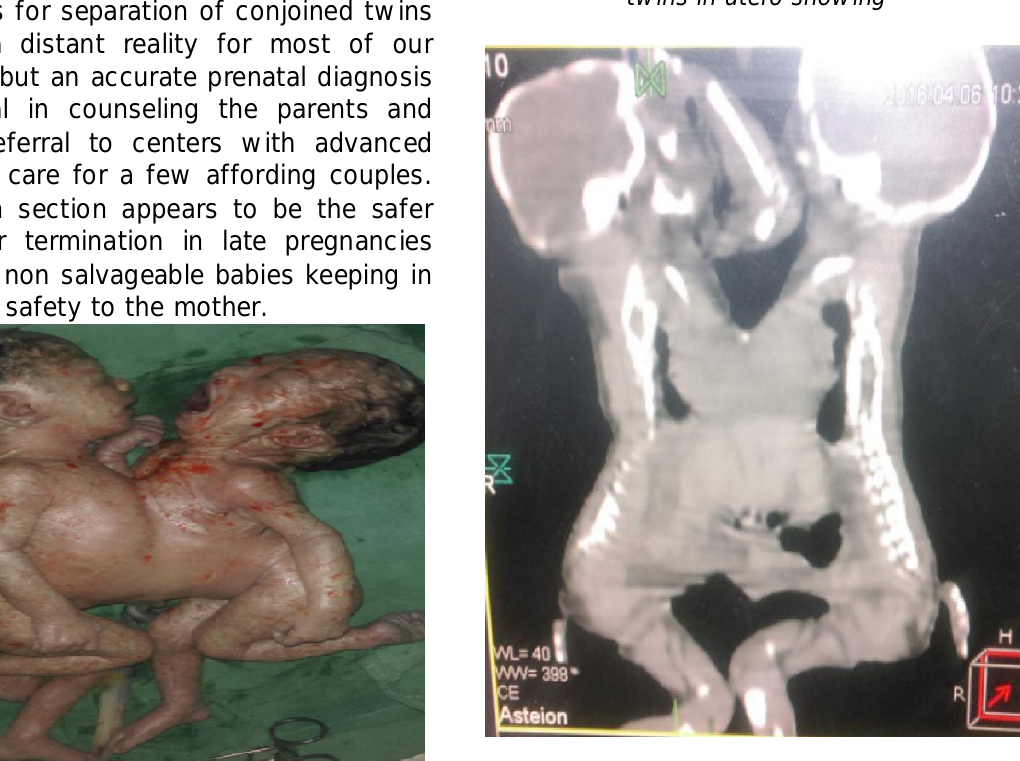
Figure 2: X-Ray of the mother with conjoined twins in utero showing